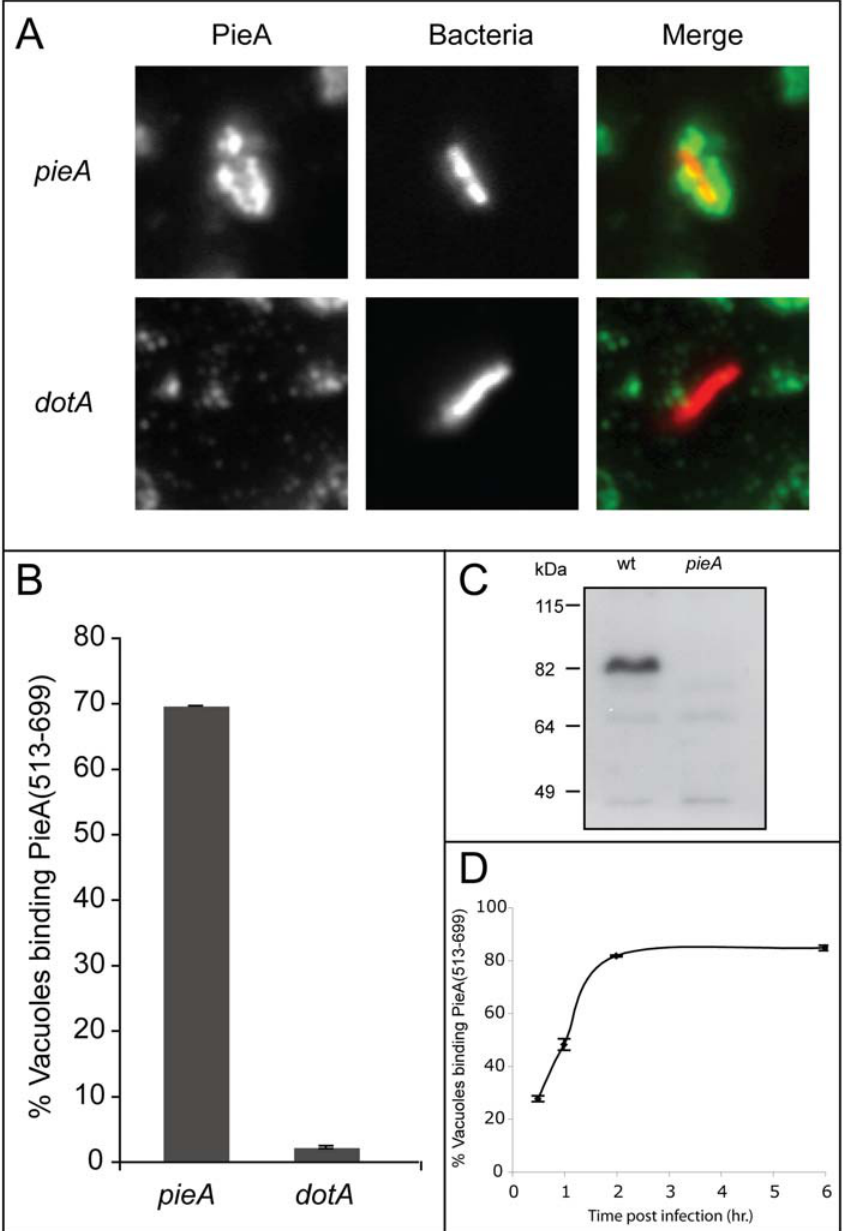
Figure 6. PieA binds invitro to vacuoles containing L.pneumophila with an intact Dot/Icm system, but not to vacuoles containing a dotA mutant. L. pneumophila vacuoles were isolated from U937 macrophage-like cells infected with either a pieA mutant or a dotA mutant strain expressing the fluorescent protein DsRed. (A) Representative epifluorescent micrographs of L. pneumophila containing vacuoles that were incubated with purified PieA(513–699) protein. Bound protein (PieA) was detected using a polyclonal antibody directed against PieA and was found on vacuoles containing the pieA strain, but not on vacuoles containing the Dot/Icm deficient strain dotA . (B) L. pneumophila containing vacuoles were scored to quantify the percent of vacuoles that bound to PieA. Values are means 6 standard error of mean for three independent experiments in which 300 vacuoles were scored for each condition. (C) An immunoblot probed with an a PieA antibody. A specific band corresponding to a protein with the same molecular weight predicted for the pieA product was detected in whole-cell lysates from wild-type L. pneumophila . The a PieA–reactive product was not detected in lysates isolated from pieA mutant L. pneumophila . The positions of molecular weight standards (kDa) are indicated to the left of the immunoblot. (D) PieA binding to vacuoles isolated from U937 macrophage-like cells at different times post infection with wild-type L. pneumophila . Values are means 6 standard error of mean for three independent experiments. PieA binding reaches a maximum in vacuoles isolated two hours post